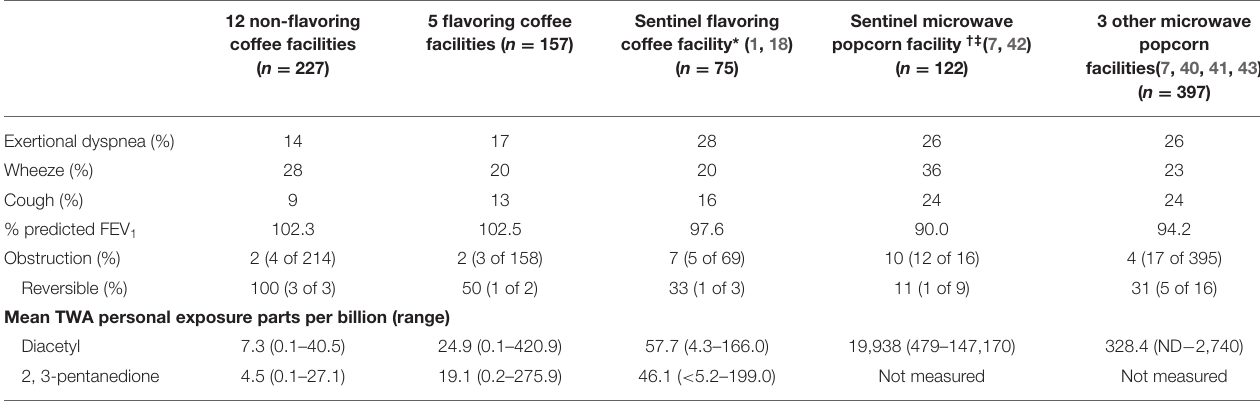
TABLE 3 | Comparison of characteristics for participants from non-flavoring coffee facilities and flavoring coffee facilities to published findings from workers in the sentinel coffee facility, sentinel microwave popcorn facility, and three other microwave popcorn facilities. 12 non-flavoring coffee